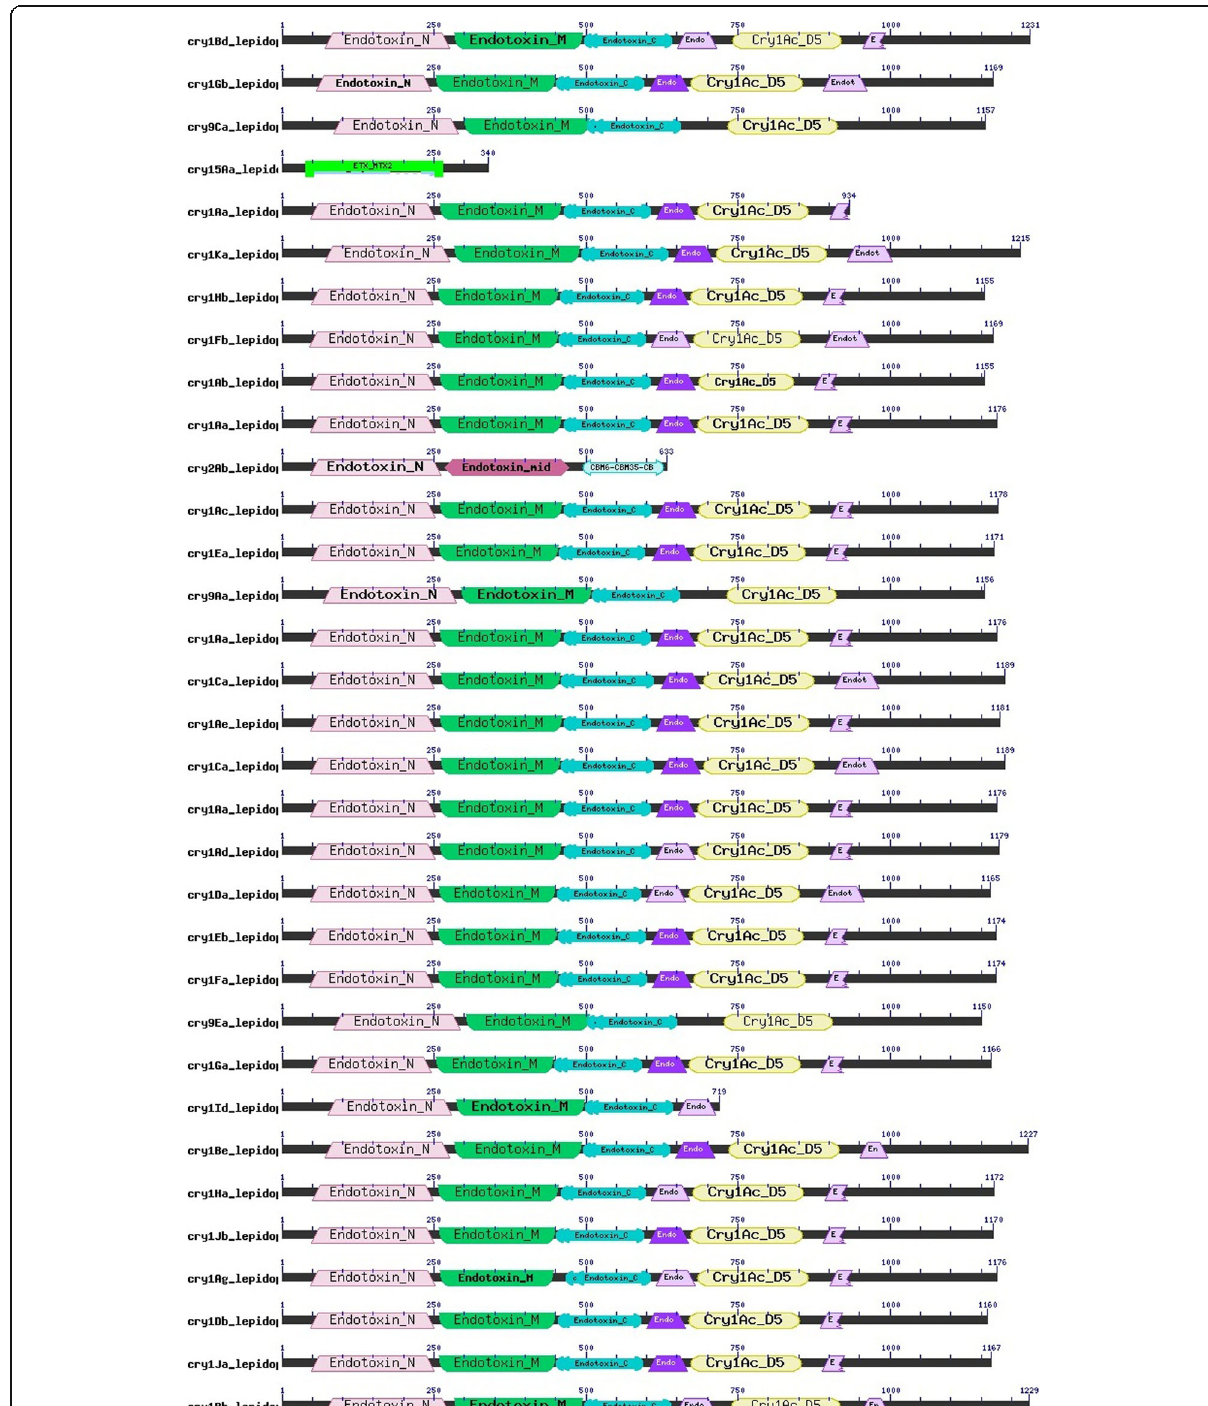
Fig. 2 NCBI batch conserved domain-search for Lepidoptera insect